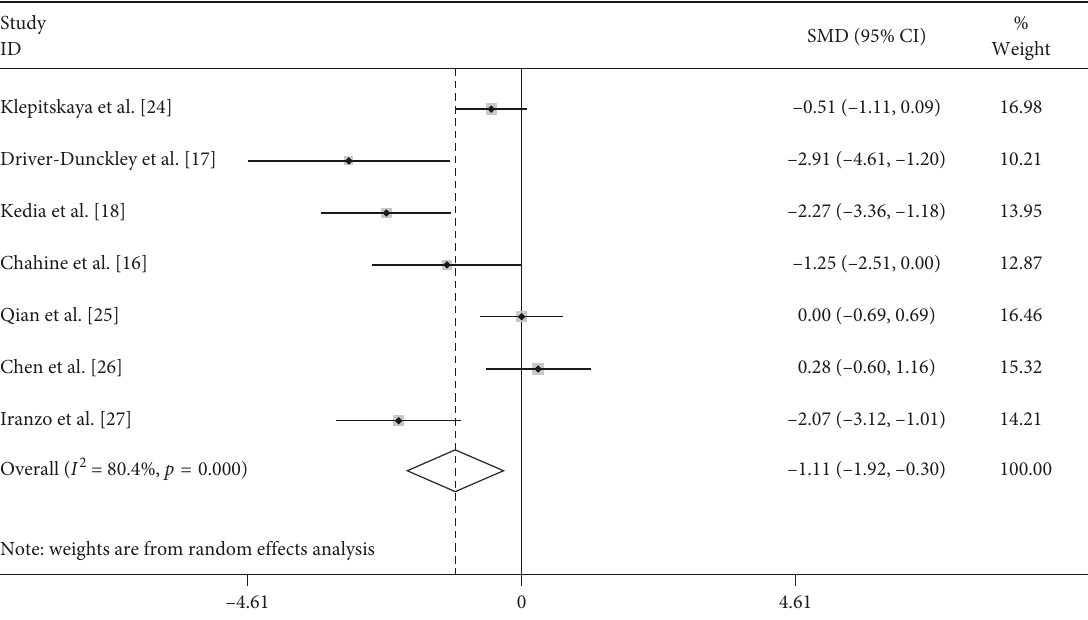
Figure 2: Forest plot for the change in sleeping symptoms observed presurgery and